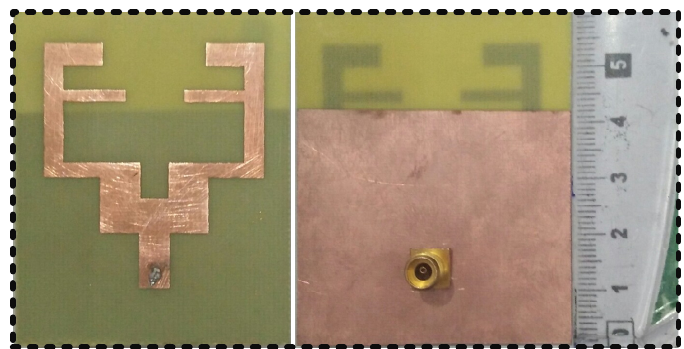
Figure 7. Front and back view of the fabricated prototype of the antenna.